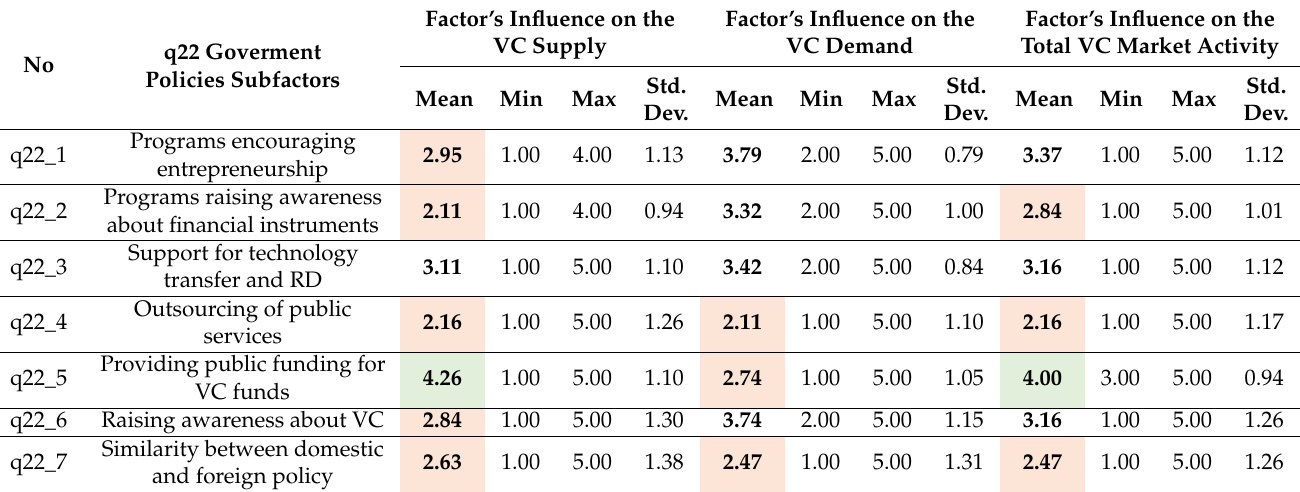
Table 12. The subfactors related to government